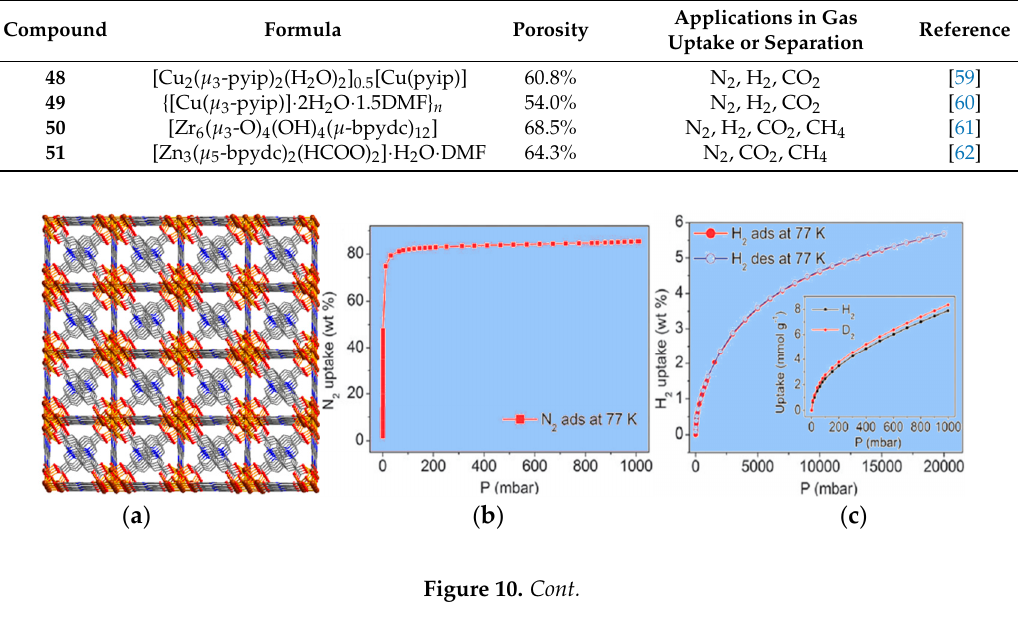
Table 8. Selected examples of highly porous metal-organic frameworks (MOFs).